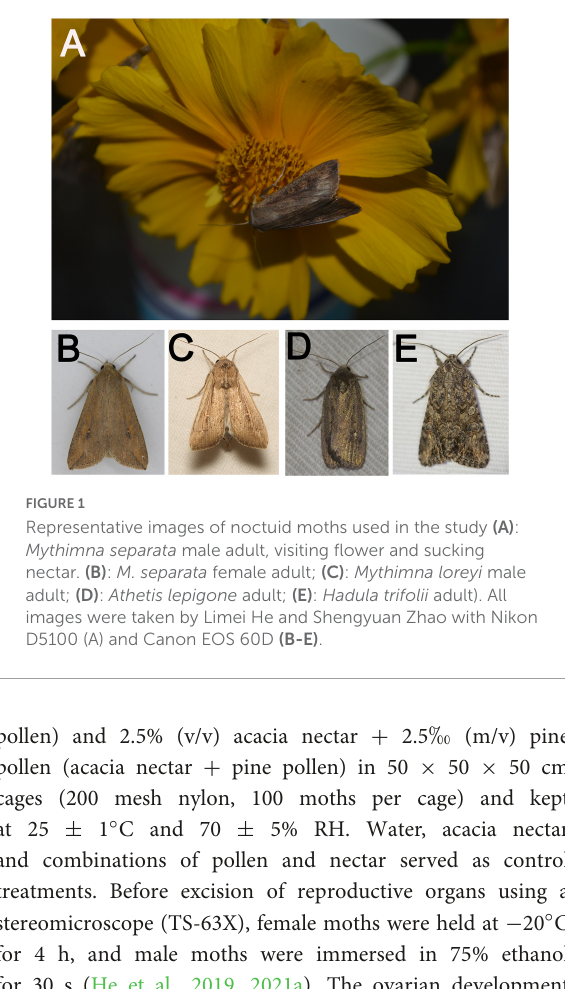
pollen) and 2.5% (v/v) acacia nectar + 2.5